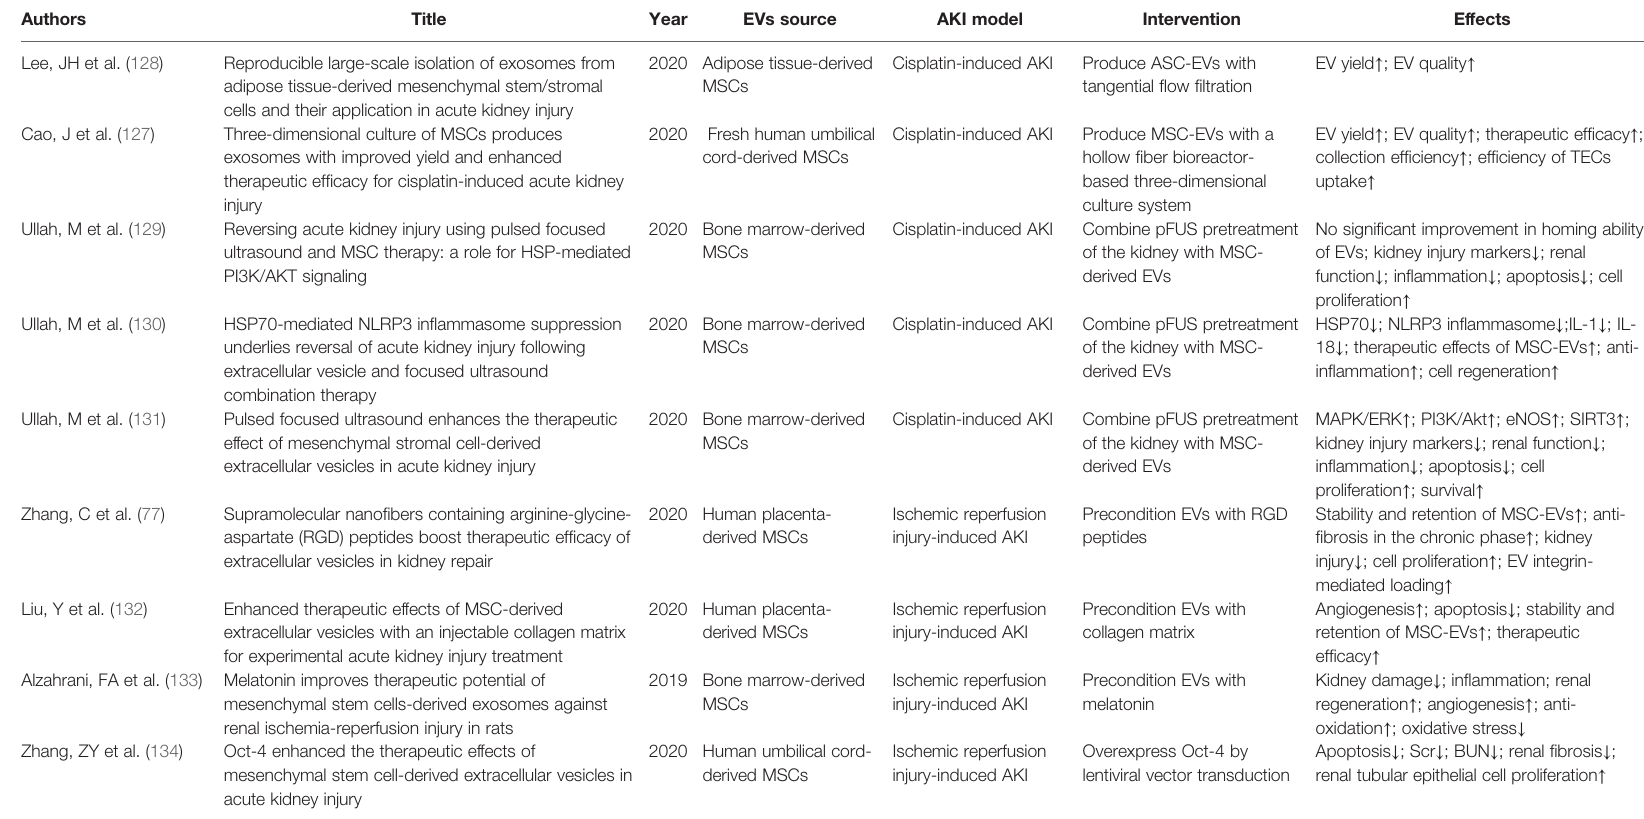
TABLE 1 | Recent research into the therapeutic effects of